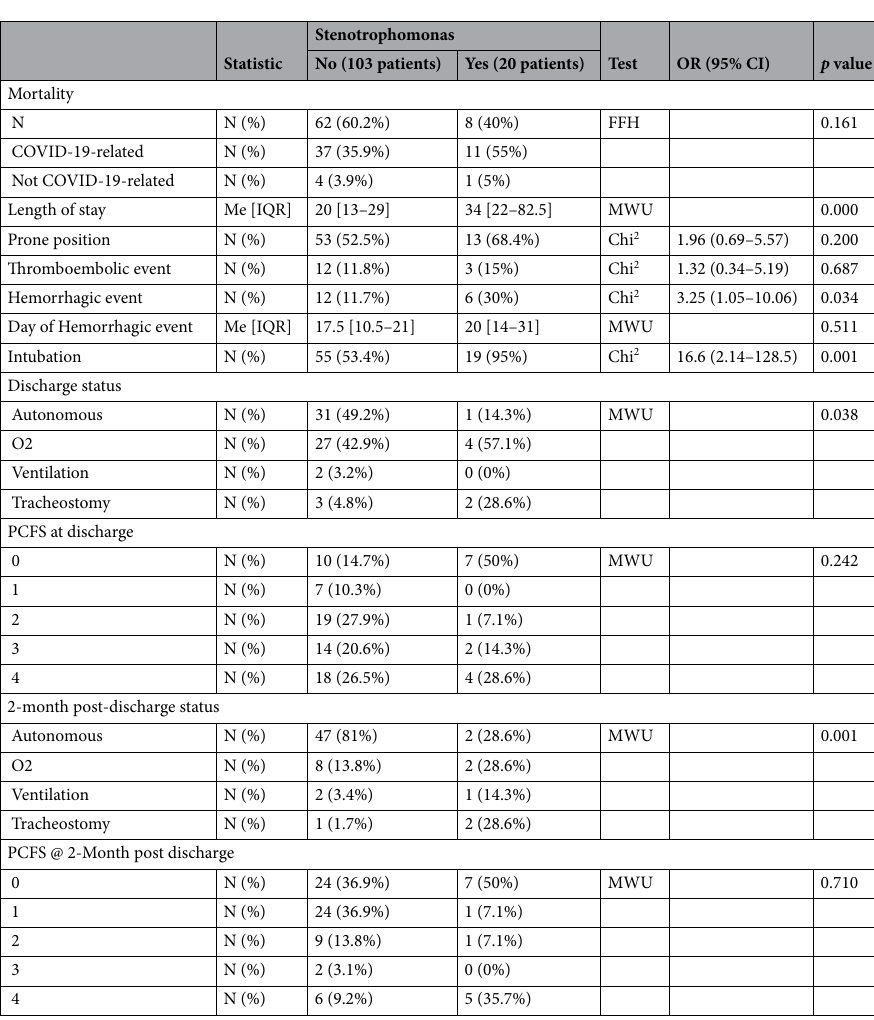
Table 4. Clinical and functional outcomes in the 2 groups without and with Stenotrophomonas infection. Categorical data are presented as frequencies and percentages (N (%)); Continuous data departing from normality assumptions and ordinal data are presented as Median with its interquartile range (1st quartile–3rd quartile) (Me [IQR]). Chi 2 : Chi square test; MWU: Mann–Whitney U test; PCFS: Post-COVID-19 Functional Status. For binary data, the odds ratio with its 95% confidence interval were calculated [OR (95% CI)]. FFH: Fisher–Freeman–Halton exact test. T: independent samples T